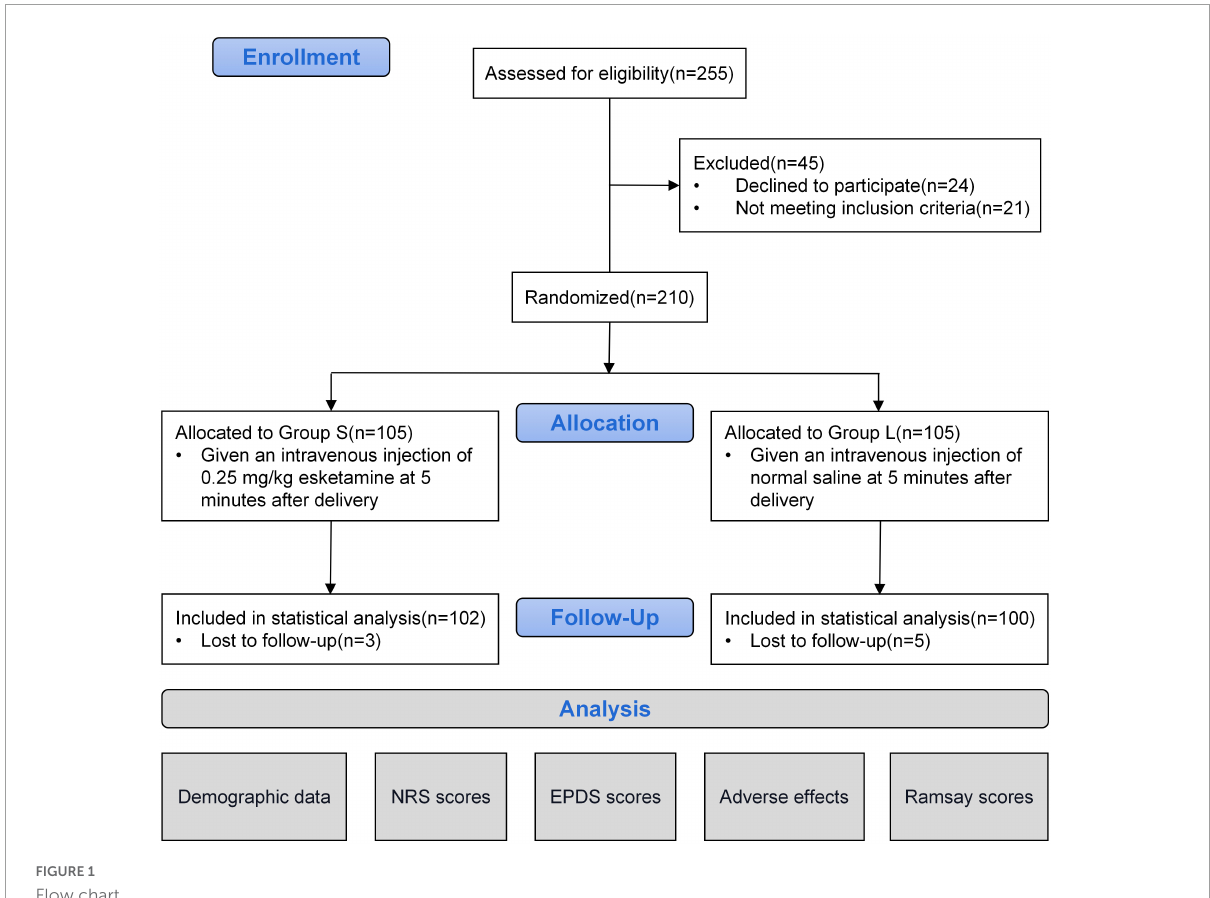
FIGURE1 Flow chart.